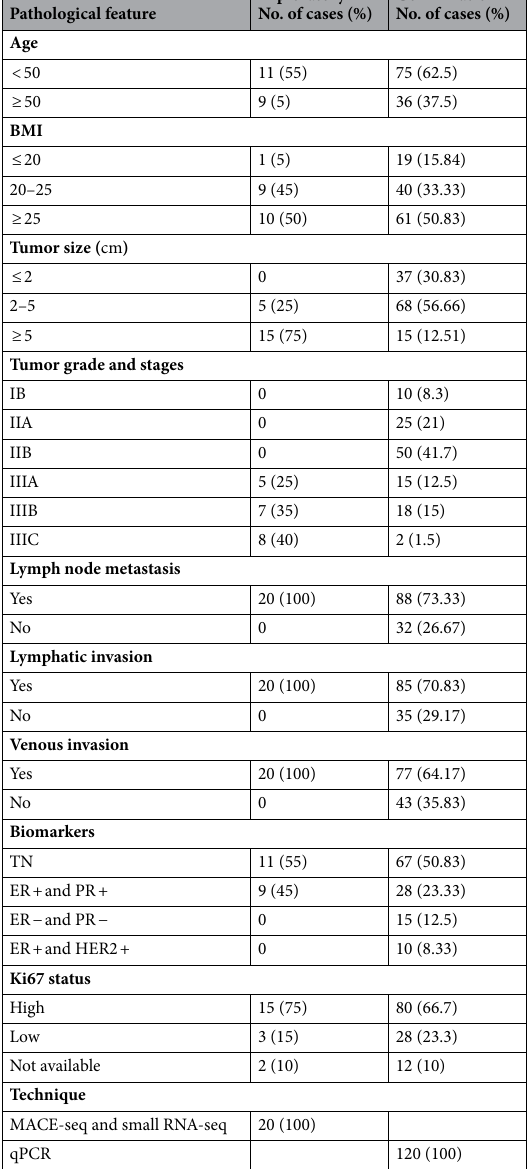
Table 1. Features of clinical pathology of 120 BC participants. BMI Body mass index, TN Triple negative, ER Estrogen Receptor, PR Progesterone Receptor, HER2 Human Epidermal Growth Factor Receptor